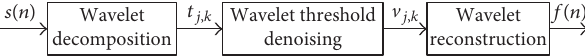
Figure 1: Wavelet threshold denoising process, where 𝑠(𝑛) is the original noisy signal, 𝑡 𝑗,𝑘 is the wavelet coefficient obtained from the wavelet decomposition of 𝑠(𝑛) , 𝑡 𝑗,𝑘 includes the approximate coefficient 𝑐 𝑗,𝑘 and the detail coefficient 𝑑 𝑖,𝑘 , V 𝑗,𝑘 is the estimated wavelet coefficient after wavelet threshold denoising, and 𝑓(𝑛) is the estimated 𝑠(𝑛) obtained from the wavelet reconstruction of V 𝑗,𝑘 .